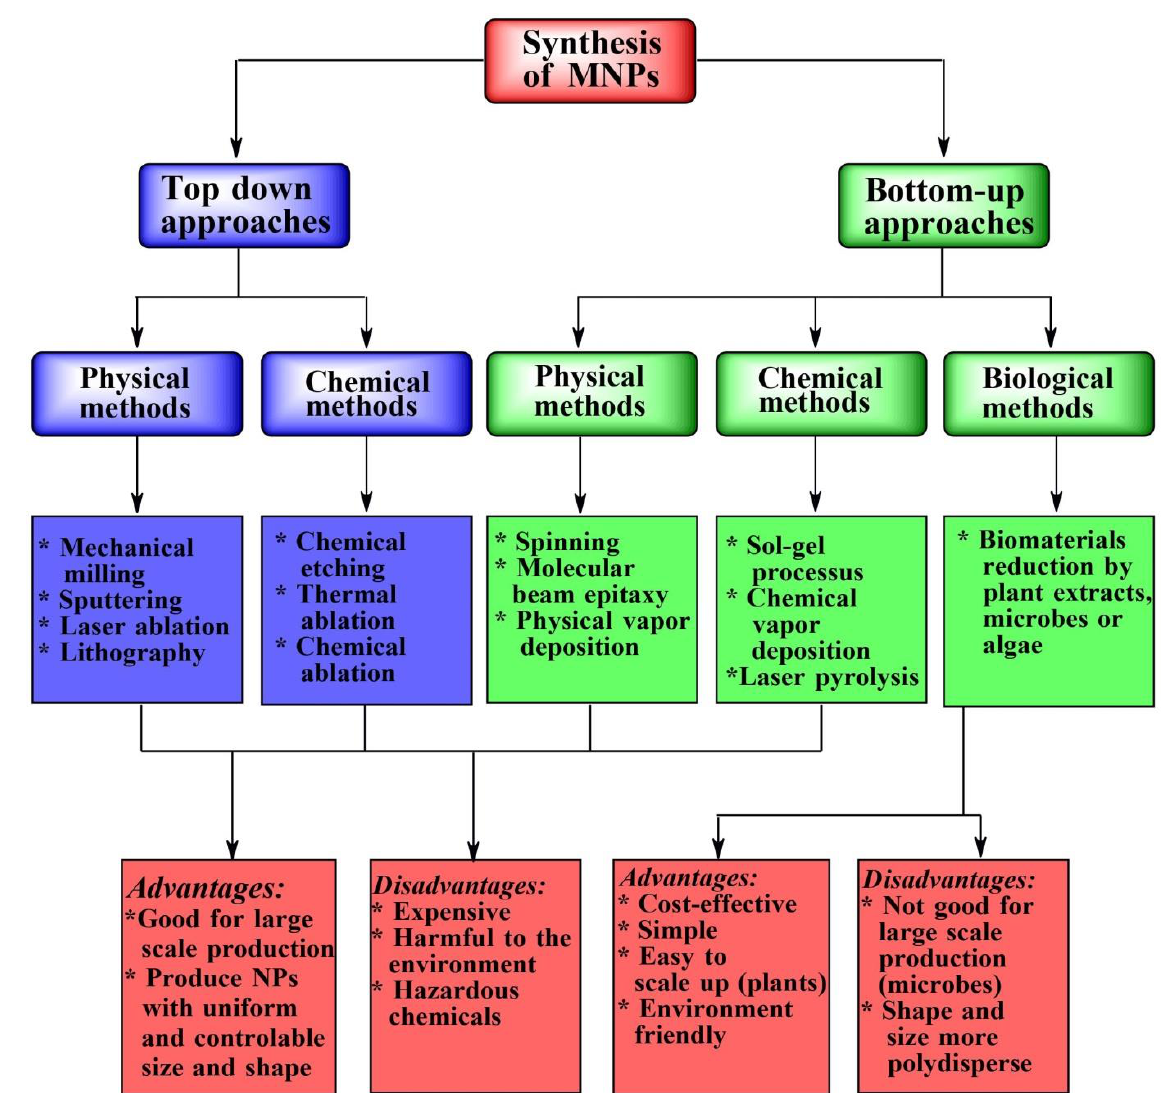
Figure 3. Overview of the synthesis of metal